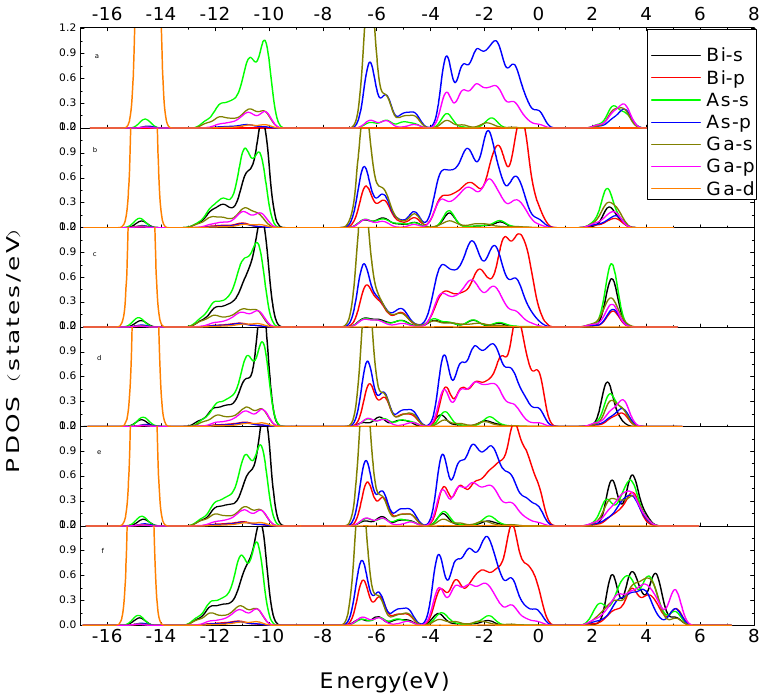
Figure 2. The PDOS of GaAs ( e ) x = 6.3%; ( f ) x =